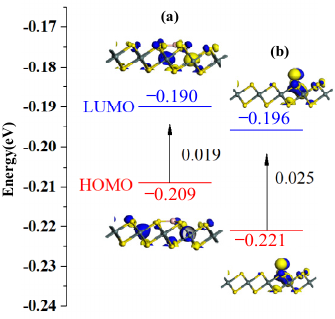
Table 1. Energy of HOMO, LUMO, and energy gap of B-SnS 2 and N-SnS 2 .